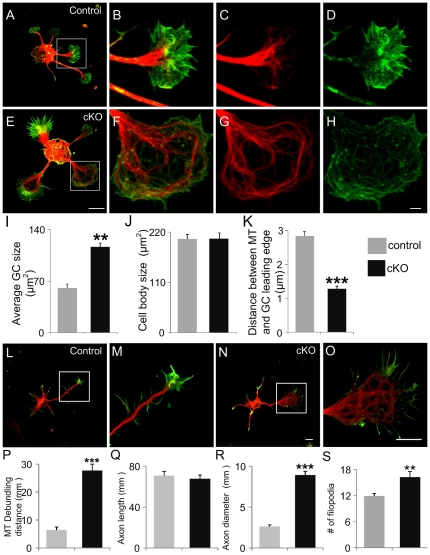
APC deletion induces cytoskeleton reorganization at axonal growth cones.(A and E) Control (A) and APC cKO (E) cortical neurons fixed at 1DIV and double stained with phalloidin (green) and anti-α-tubulin antibody (red). (B–D and F–H) Higher magnification images of control (B–D) and APC cKO (F–H) growth cones from the inserts shown in A and E. Note that microtubules gradually splay apart and extend towards the central domain of the growth cone in control neurons (C); in contrast, microtubules are highly debundled and disoriented in APC deficient growth cones. Disruption of F-actin allows microtubules to reach the growth cone leading edge (G). (I) Growth cone sizes of control and APC cKO neurons. (J) Cell body sizes of control and APC cKO neurons. (K) Distances between microtubule tips and the growth cone leading edge. Note microtubule tips frequently reach the leading edge in APC cKO growth cones. (L and N) Control (L) and APC cKO (M) cortical neurons fixed at 2DIV and double labeled with phalloidin (green) and anti-α-tubulin antibody (red). (M and O) High-magnification images of control and APC cKO growth cones from the inserts shown in L and N. (P) Distance of the debundled microtubules measured from the axon distal end to the point at axon shaft where microtubules are tightly bundled. Note that microtubules are debundled for a long distance at the distal part of APC cKO axons while microtubule debundling is restricted at the tip of control axons. (Q) Axon length. (R) Axon diameter at the thickest point. (S) Filopodia number at the growth cone of control and APC cKO neurons. n>60 neurons for both control and APC cKO conditions. **: P<0.005 and ***: P<0.001 by two-tailed student t-test. Data are presented as mean ± SEM. Scale bars: (A and E) 10 µm; (B–D and F–H) 2 µm; (L–O) 10 µm.